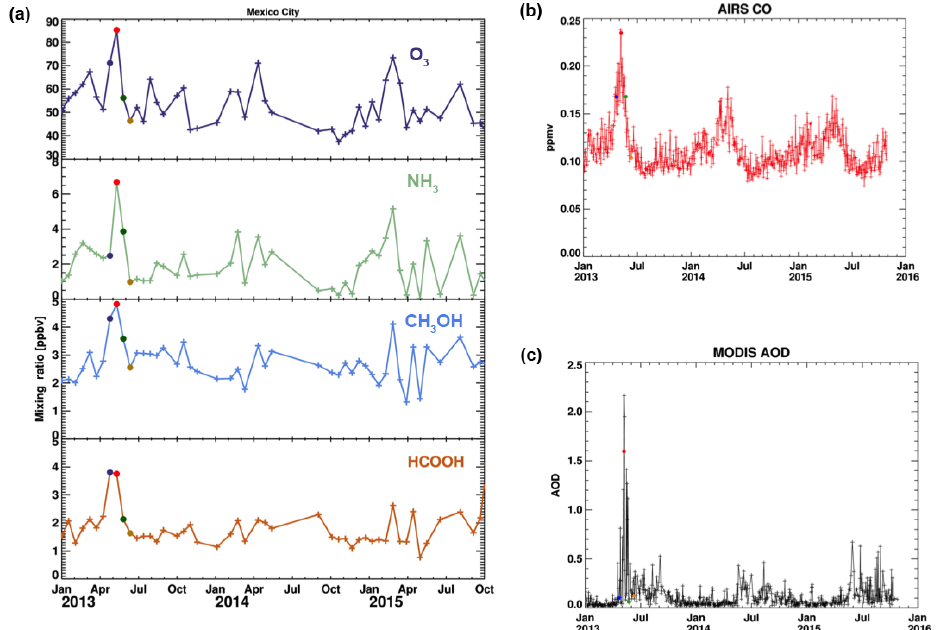
Figure 3. (a) Means of the lower levels (see text for definition) of each TES transect over the MCMA; circles mark dates discussed in text: blue: 23 April; red: 9 May; green: 25 May; gold: 10 June. (b, c) AIRS CO at 850hPa (b) and MODIS Deep Blue AOD (c) 1 ◦ × 1 ◦ data averaged over the grid boxes traversed by the transect.